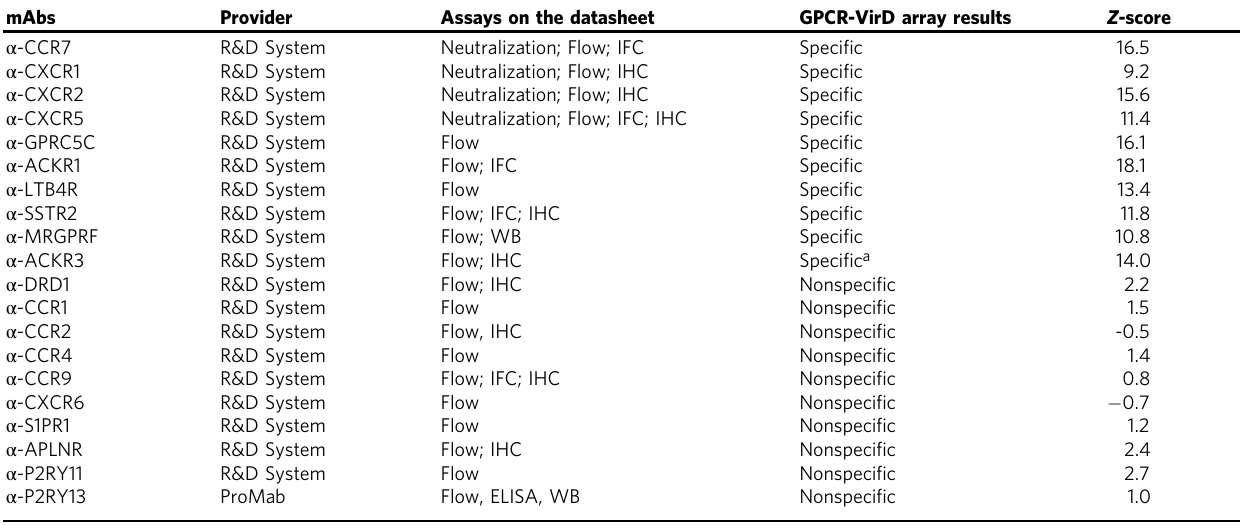
Table 1 Binding speci fi city for 20 commercial mAbs using VirD-GPCR arrays mAbs Provider Assays on the datasheet GPCR-VirD array